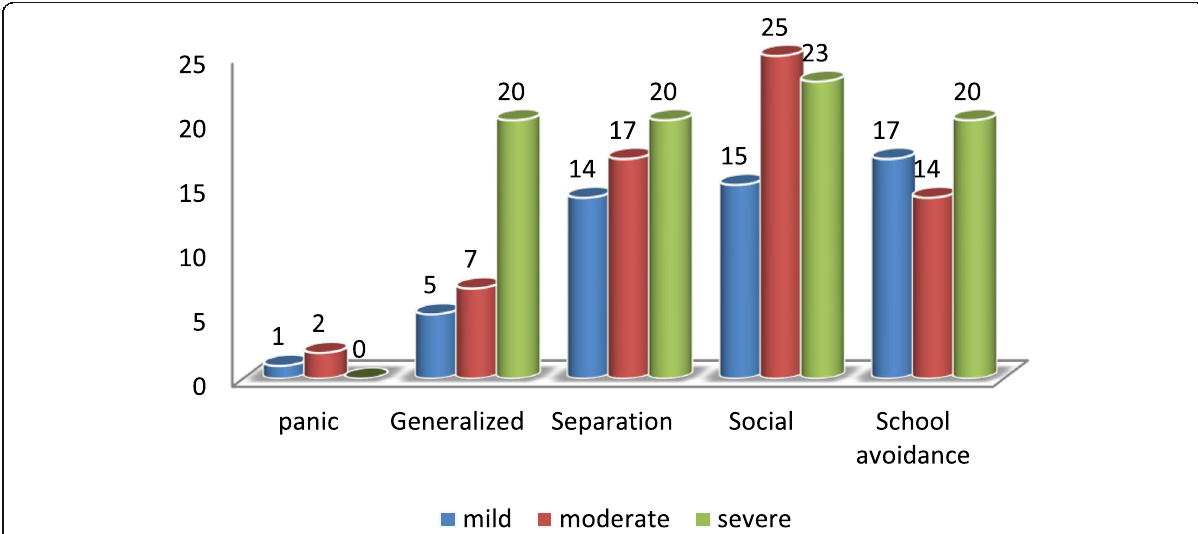
Fig. 1 Subtypes of anxiety test as regards the no. and % show significant difference between the three groups A, B, and C (mild, moderate, and severe hearing impairment) in generalized and social disorders (value =.0001) and there was no significant difference between the three groups in panic (value= .353), separation and school avoidance disorders